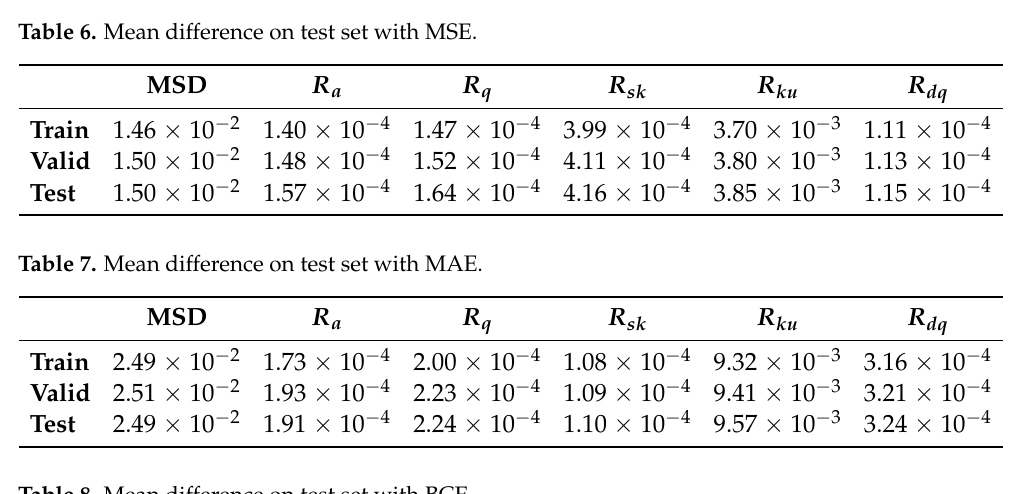
Table 8. Mean difference on test set with